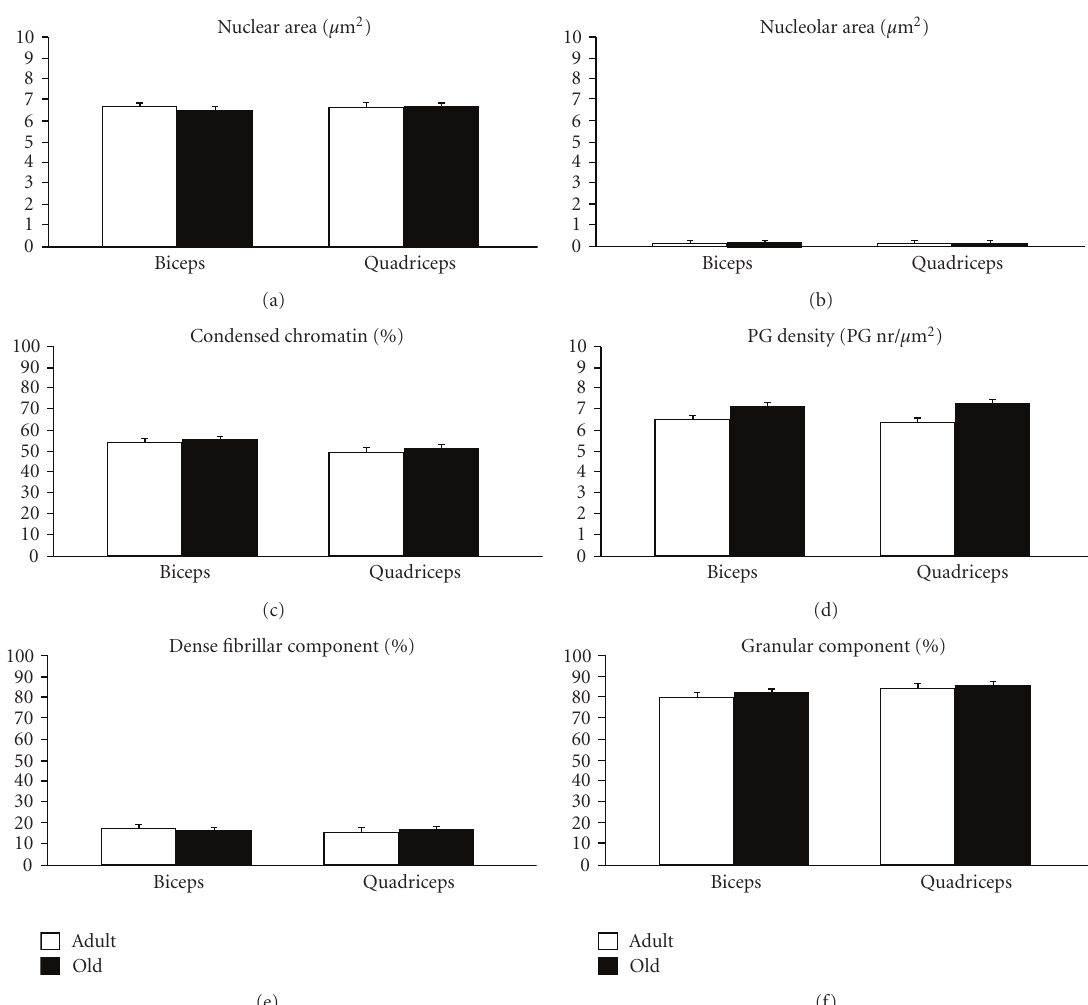
Figure 3: Morphometrical parameters measured on electron micrographs of satellite cell nuclei from the biceps and quadriceps muscles of adult and old rats (mean ± SE). No significant di ff erence was found between the two ages.